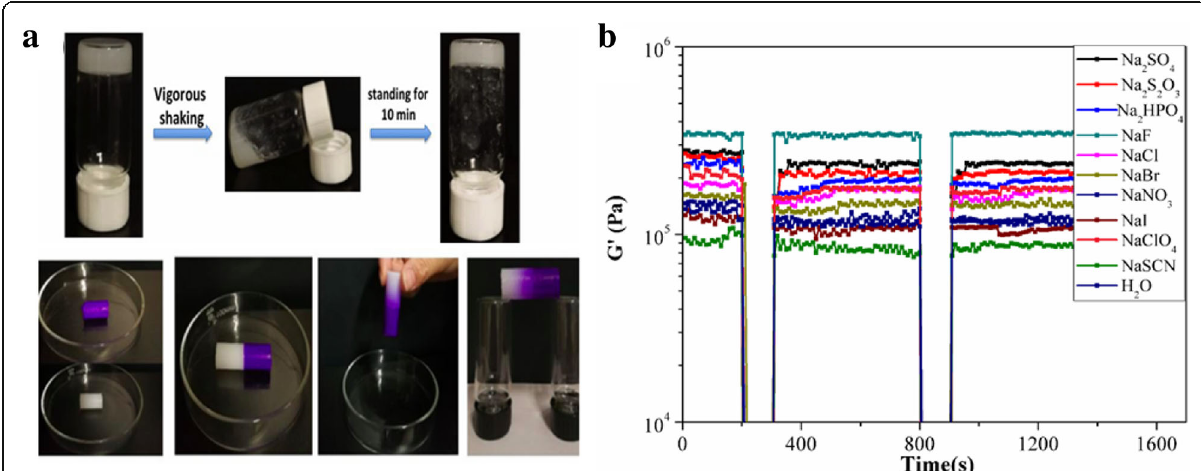
Fig. 3 a Illustration of self-healing properties of the G1 gels (2.0% w / v ) obtained from undoped gel and blue dye-doped gel. b Time scan tests under alternating strain of 0.1% and 100% of G1 (2.5% w / v ) with Hofmeister salts (concentration is 0.5 M) with a fixed frequency at 1 Hz at 25